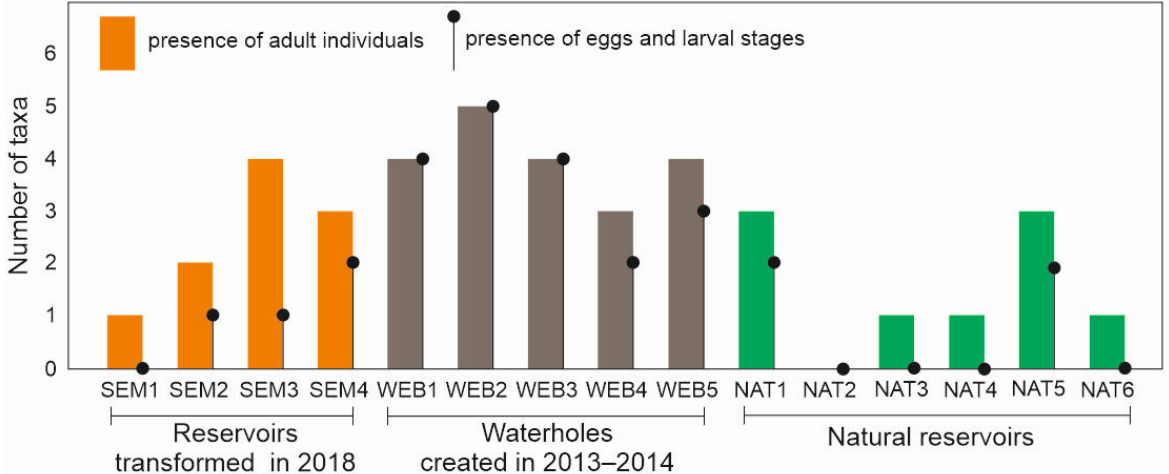
Figure 5. Number of amphibian taxa found in the examined water reservoirs in 2018.